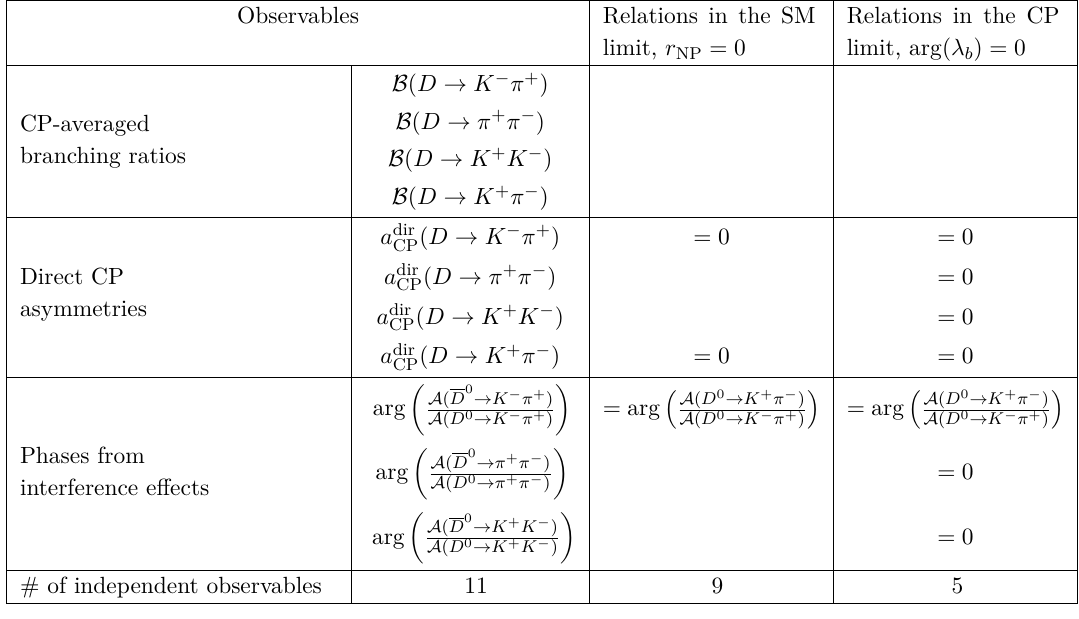
Table 2 . Available observables in the D 0 → P + P − system, and relations between them in the SM limit and in the CP